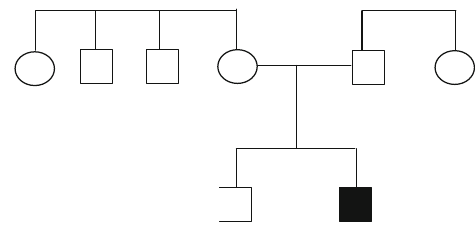
Figure 1: The genealogy of the presenting patient.